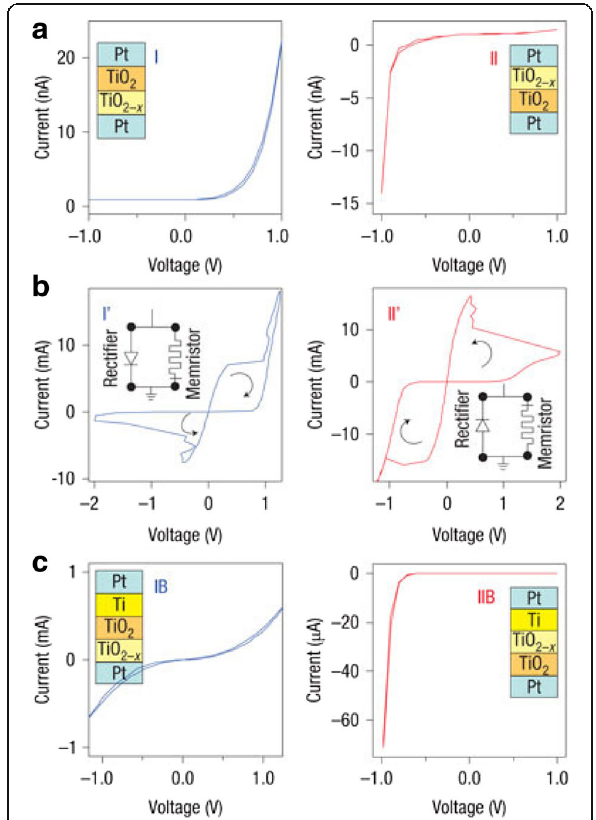
Fig. 4 Thin-film TiO 2 − x devices with controlled oxygen vacancy profiles are used to verify the switching mechanism. a Samples I and II contain reversed layer sequences of 15-nm TiO 2 and 15-nm TiO 2 − x (more vacancies) layers. These show opposite polarities of I-V curves in their virgin states. b . The switching polarities of these two samples are also opposite to each other. c . When more vacancies are introduced by adding a 5-nm Ti layer to the top interfaces of these two samples, the I-V curves change in totally different ways, confirming the domin- ant role of then non-ohmic interfaces in the thin-film devices